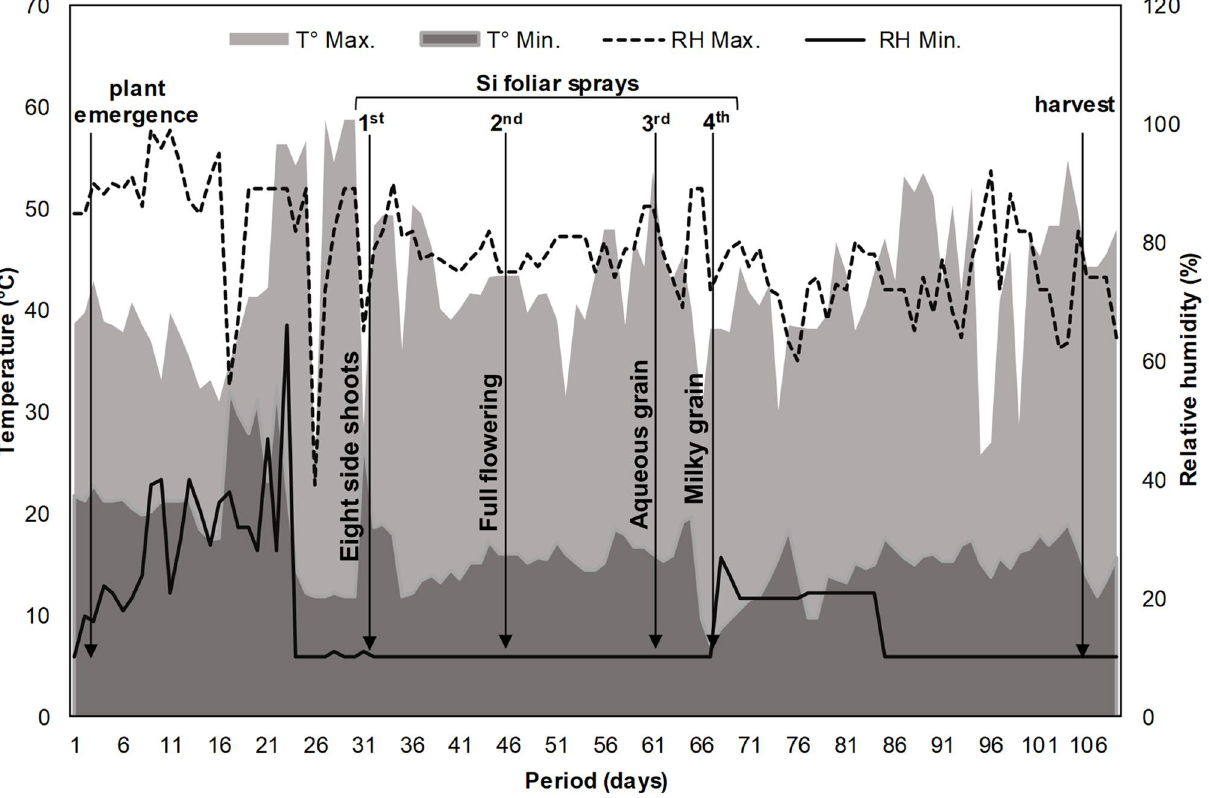
Figure 6. Experimental conditions inside the greenhouse used in this study. Maximum temperature (T° Max.), minimum temperature (T° Min.), maximum relative humidity (RH Max.), and minimum relative humidity (RH